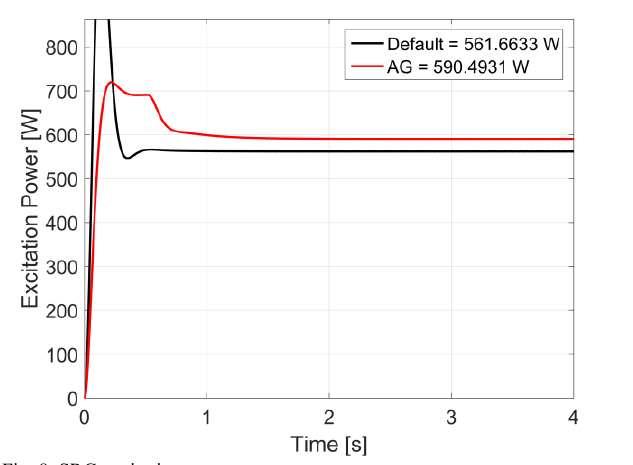
Fig. 8. SRG excitation power.